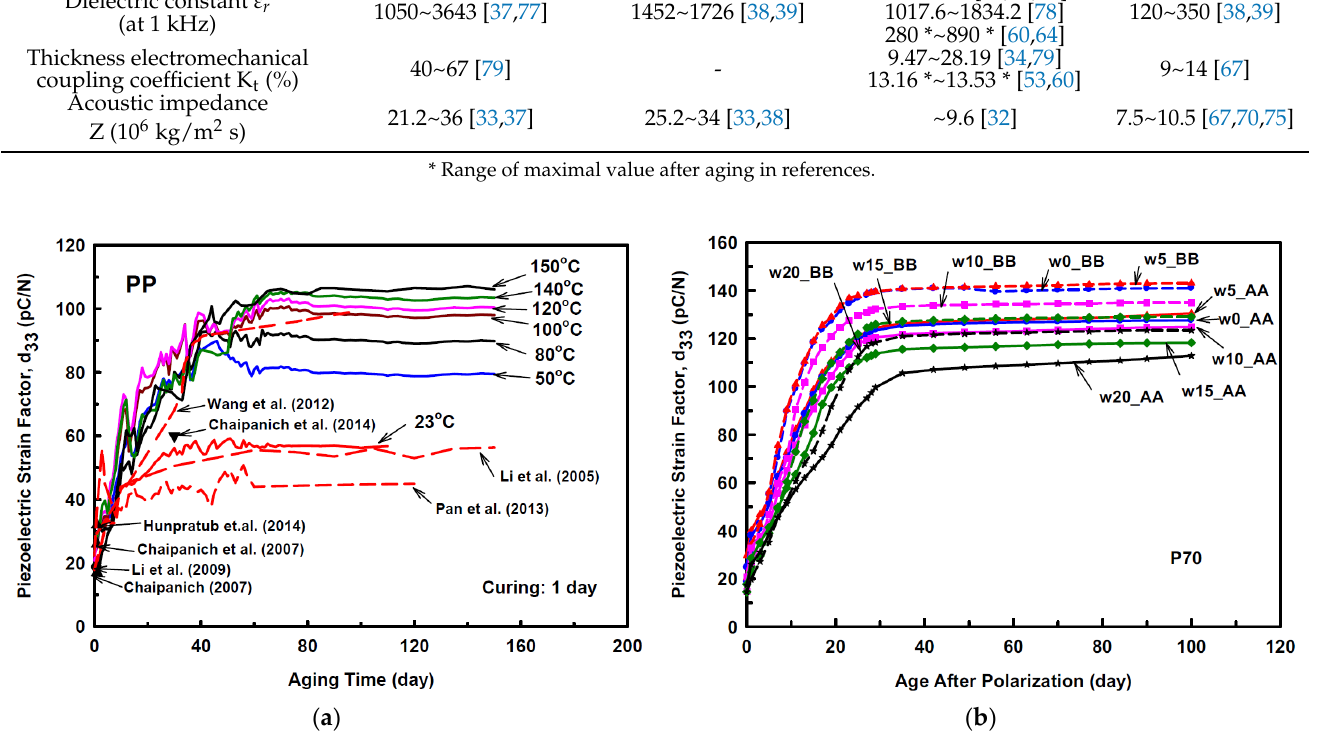
Figure 1. ( a ) Piezoelectric strain constant of cement piezoelectric composites. Reprinted with permission from ref. [83]. Copyright 2016 Elsevier. ( b ) Piezoelectric strain factor of 70% PZT/cement composites versus age. Reprinted with permission from ref. [64]. Copyright 2013